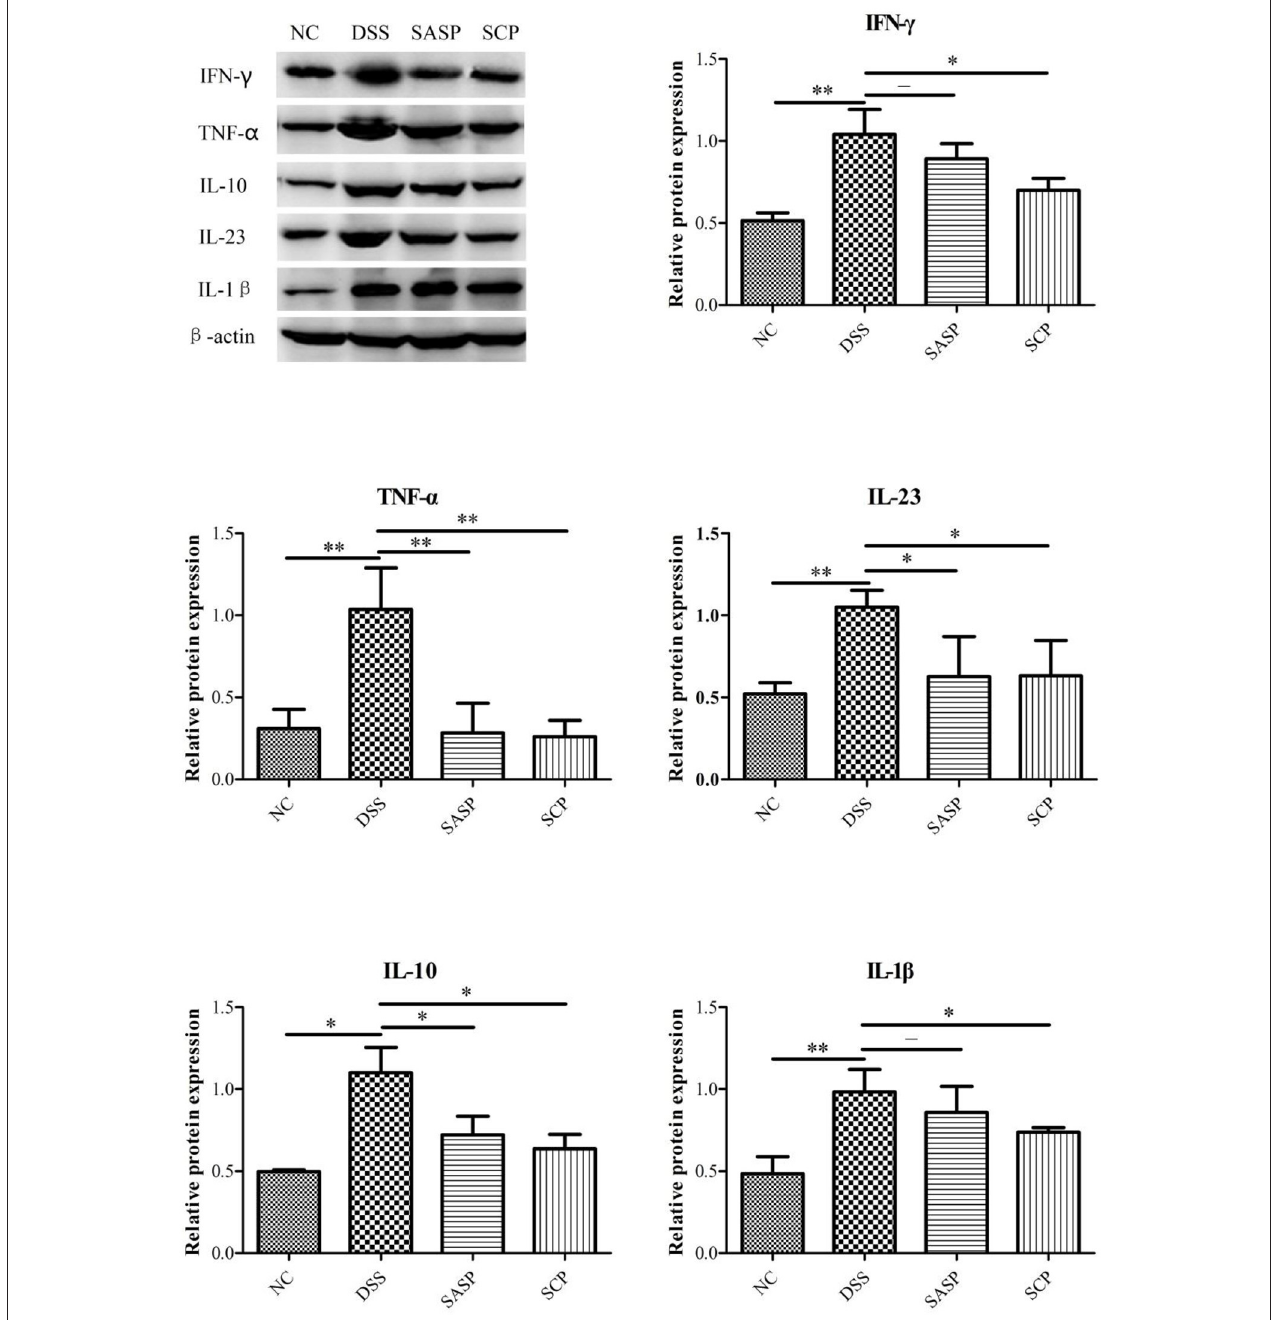
FIGURE 5 | Expression level of key proteins. NC, control group; M, DSS group; SASP, positive drug group; SCP, S. chinensis polysaccharide group. Data are expressed as means ± S.D. * p < 0.05, ** p < 0.01, *** p <